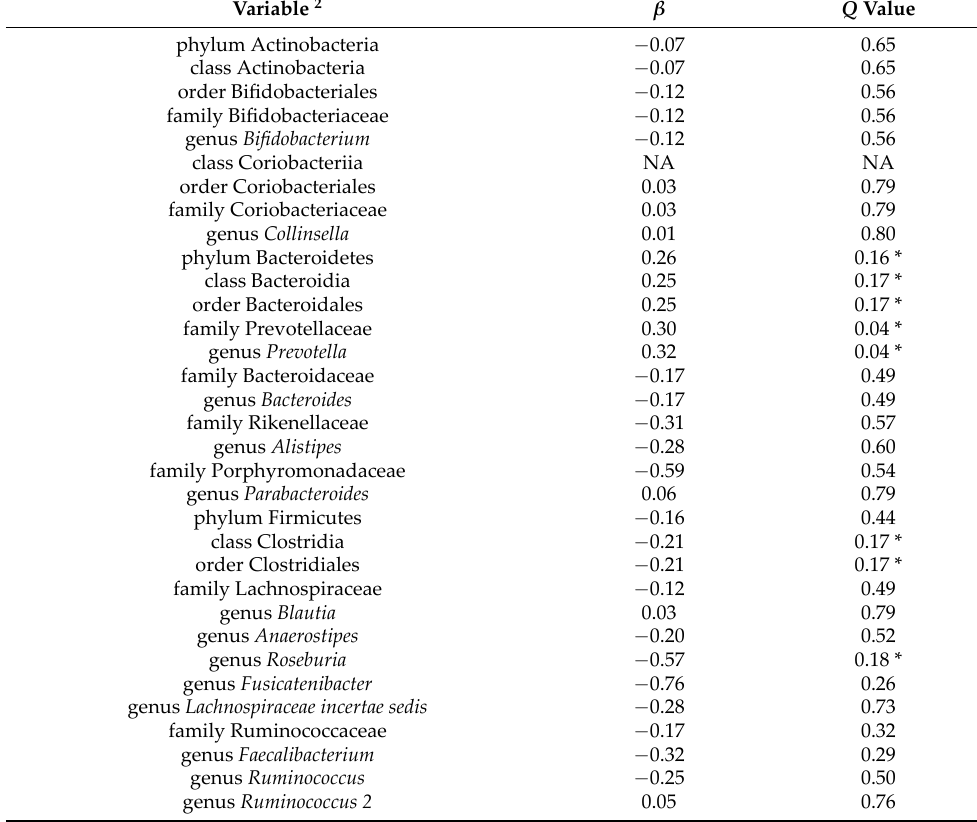
Table 5. Association between plasma LBP concentration and intestinal microbiota composition 1